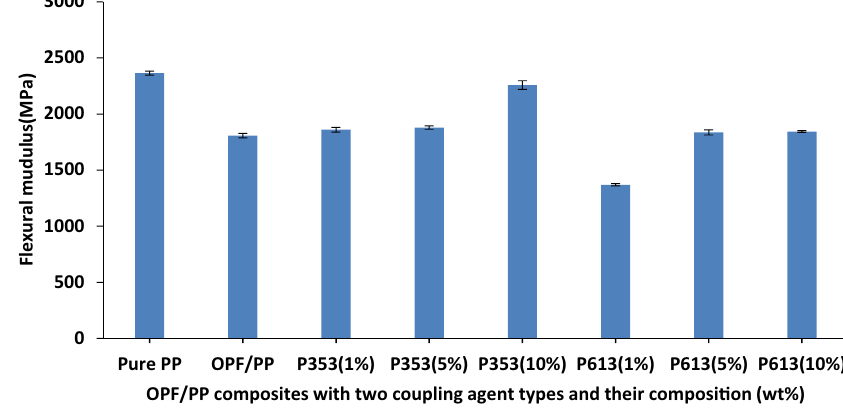
Figure 9: Flexural modulus of the pure PP, uncoupled, and coupled 20% OPF/PP polymer composite with two coupling agent types of di ff erent weight